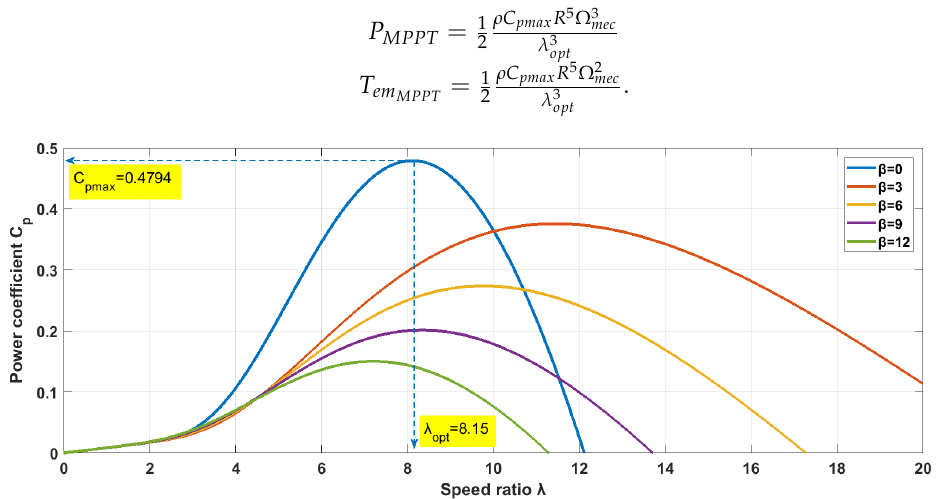
Figure 3. Cp versus λ .